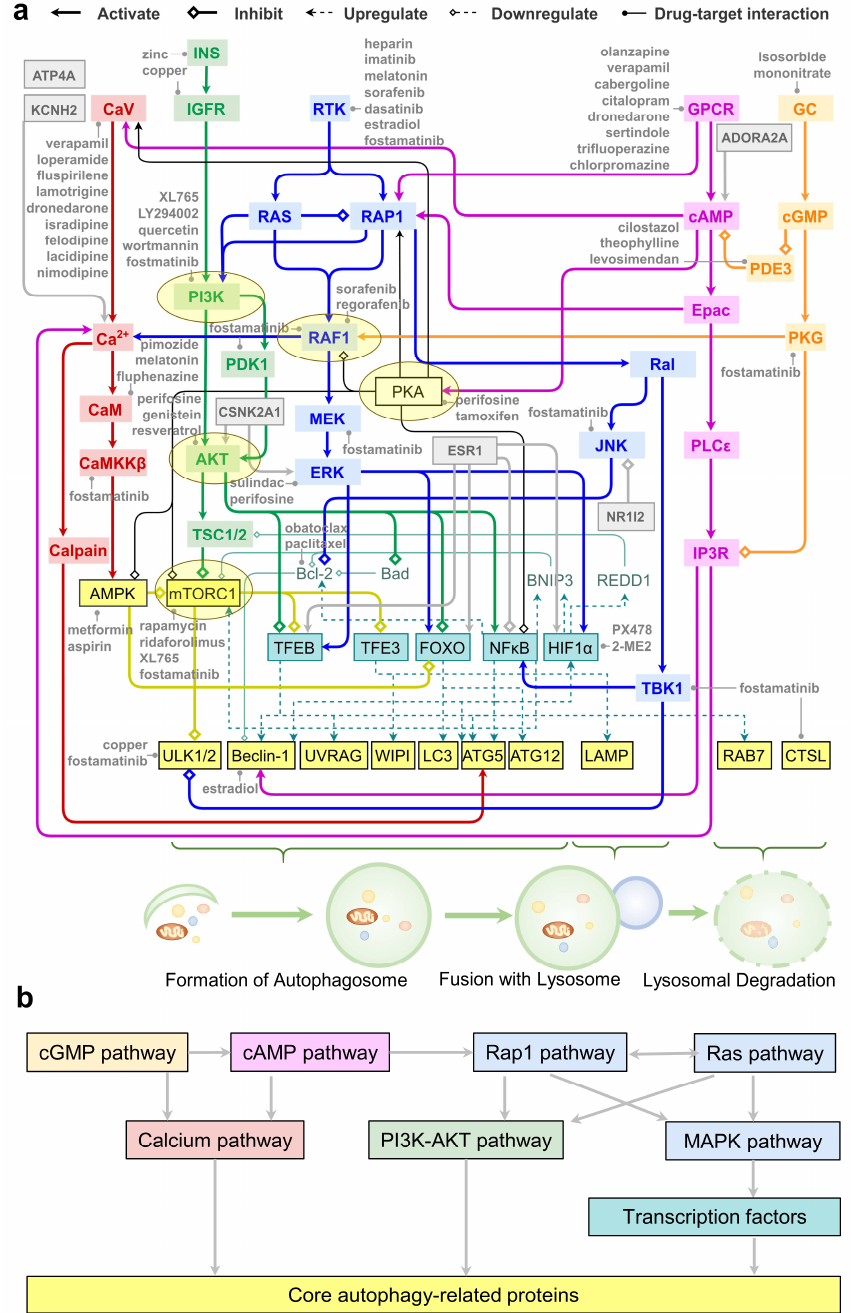
Figure 6. A network of pathways connecting intracellular signal transduction events to autophagy modulation. ( a ) A unified signaling network mediates the effects of autophagy modulators on signaling transduction; ( b ) The regulatory dependency of signaling transduction modules. Color coding: calcium signaling ( red ), cAMP signaling ( violet ), cGMP-PKG signaling ( orange ), Rap1/Ras/MAPK signaling ( blue ), PI3K-AKT signaling ( green ), core autophagy proteins ( yellow ), and transcription factors ( cyan ). The core autophagy proteins were grouped (indicated by braces) by their roles in regulating three phases of autophagy: formation of autophagosome, fusion with lysosome, and lysosomal degradation. The key ATG-signal transduction proteins shown in Figure 5a (except MEK) are highlighted by the yellow ellipses. Selected modulators of key targets are listed in gray font . See the code for different types of actions indicated by arrow ends on top.